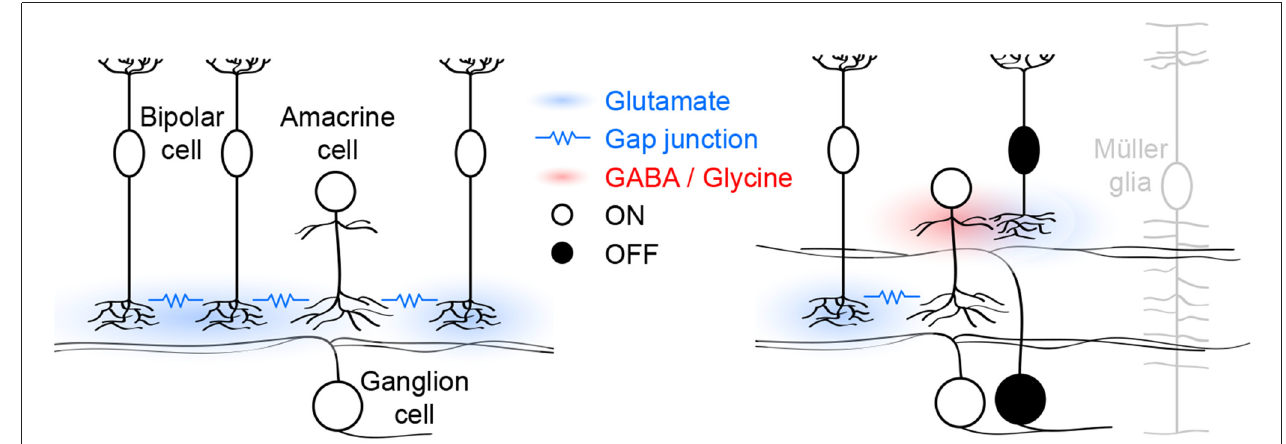
FIGURE 1 | Schematic of glutamatergic wave circuits. The left panel illustrates the lateral excitatory ( blue ) network of ON cone bipolar and amacrine cells, which generates and propagates stage III waves. Activity spreads by lateral glutamatergic transmission and gap junctions among neighboring cells. The right panel illustrates the vertical inhibitory ( red ) pathway through which ON cone bipolar cells hyperpolarize OFF cone bipolar cells and delay excitatory input to and spiking off OFF ganglion cells. Müller glia limit the spread of glutamate and maintain temporal separation of ON and OFF